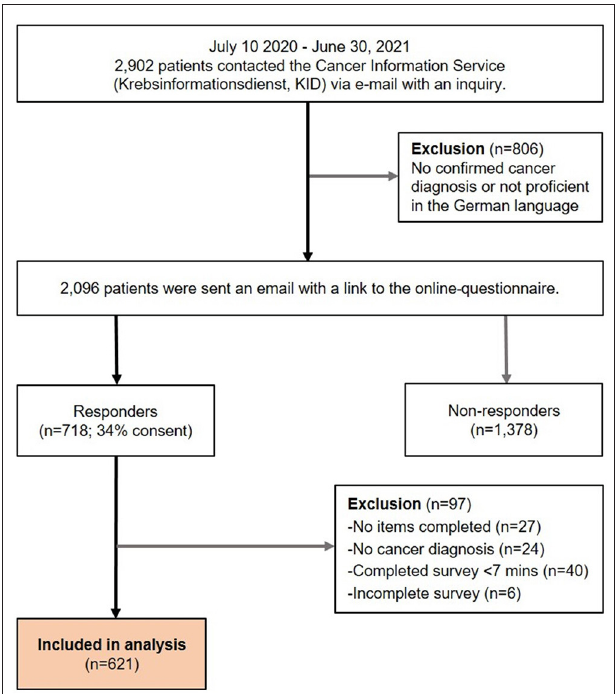
FIGURE 1 | Flow diagram of inclusion of study